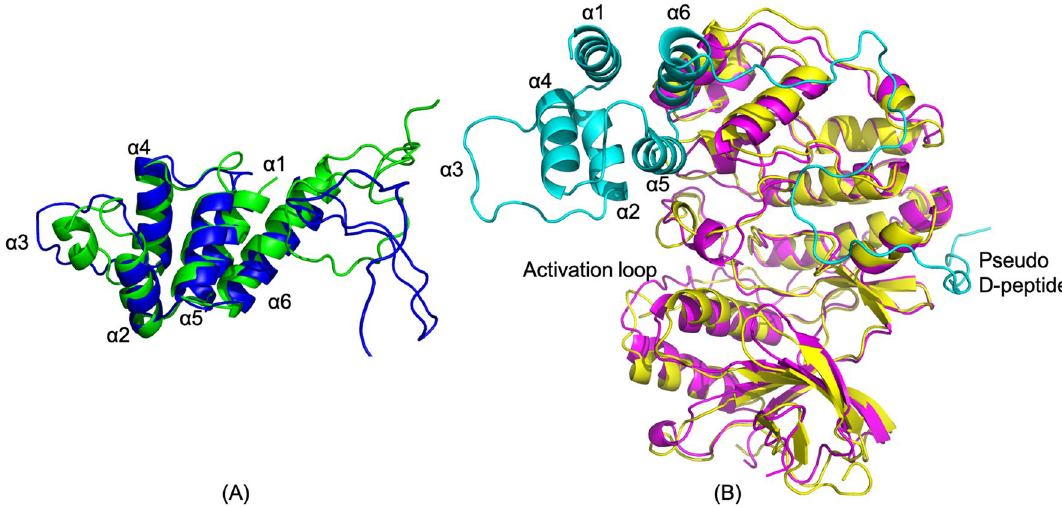
Figure 2. The simulated complex structure of PEA-15/ERK2. ( A ) PEA-15 in the complex (green) is superimposed with its free form (blue) with the RMSD 2.734 Å for the DED. Helix α3 is uncoiled and shifts in α2 and α4 can also be observed. ( B ) ERK2 in the complex is superimposed with the crystal structure of 4IZ5 with the RMSD 2.002 Å. The overall backbone of ERK2 does not show any significant difference between the simulated and crystal structure. The molecular structures were visualized and generated using PyMOL version 2.4 (http:// www. pymol.